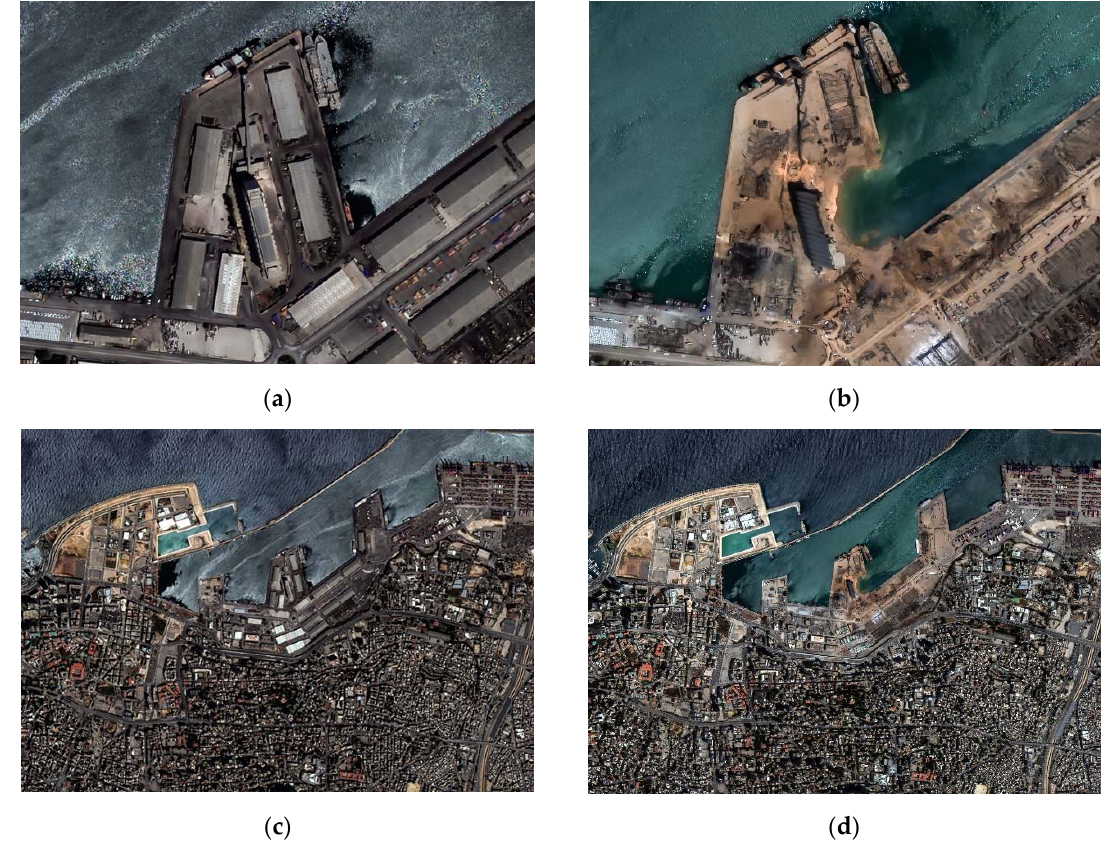
Figure 1. Top: ( a ) WorldView ‐ 2 high ‐ resolution optical image over the Beirut harbor area before the explosion and ( b ) after the event. Bottom: ( c ) WorldView ‐ 2 high ‐ resolution optical image over the broader area of the Beirut harbor before the explosion and ( d ) after the event (copyrights European Space Imaging [9]).